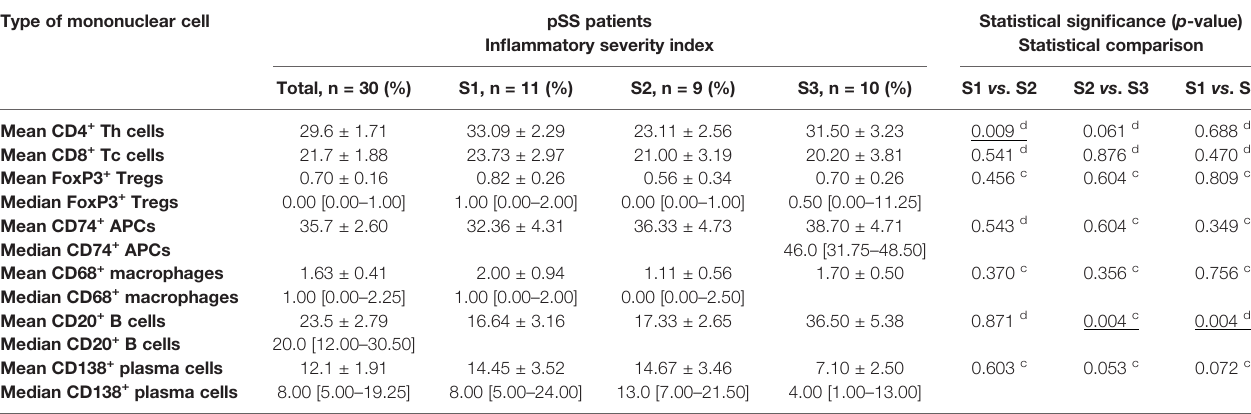
TABLE 2 | Composition of key immune cells in the focal in fi ltrates of patients included in the immunohistochemical analysis, expressed as the mean/median percentage of total in fi ltrating mononuclear cells.